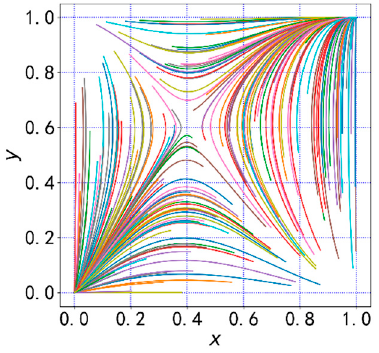
Figure 5. Initial Simulation